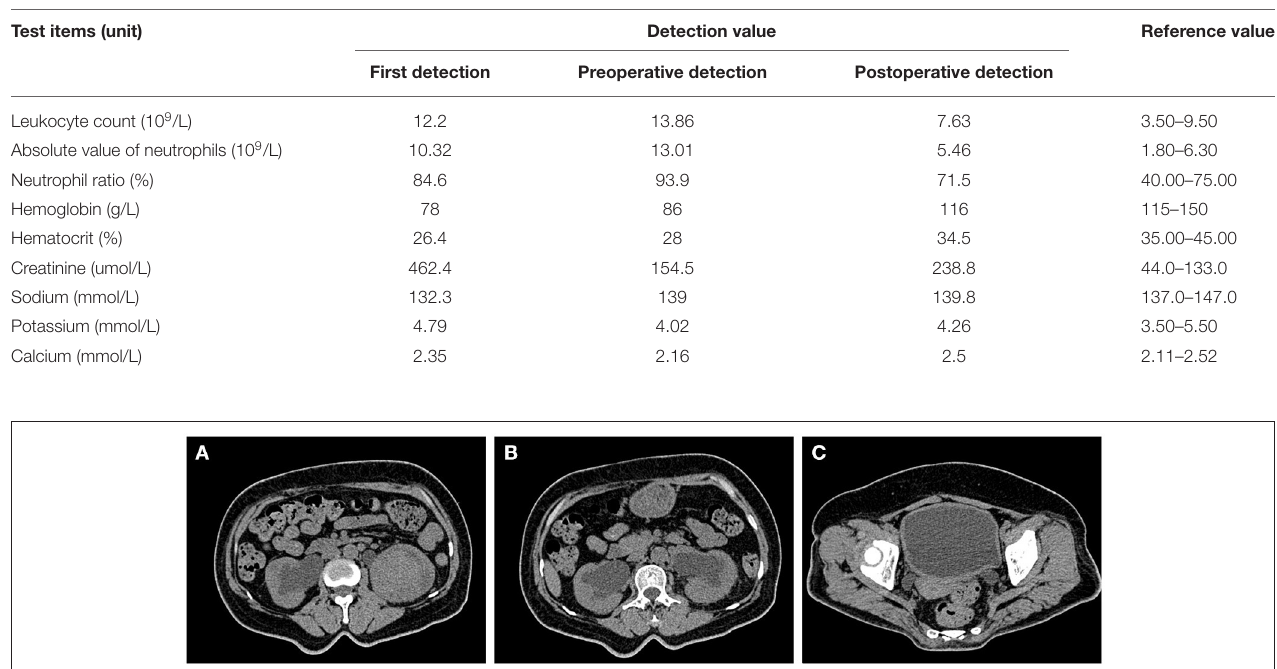
TABLE 1 | Laboratory biochemical test